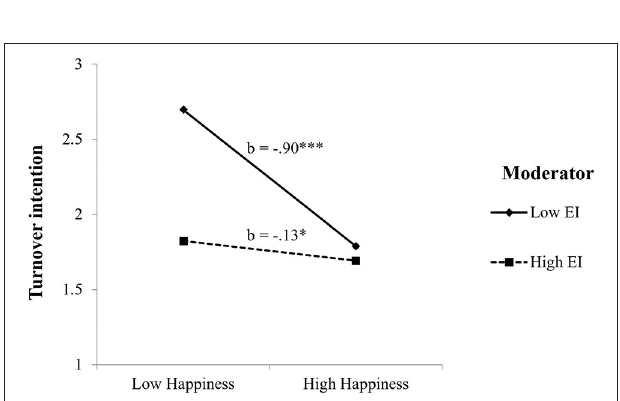
FIGURE 3 | Interaction between EI and happiness on turnover intention. *** p < 0.001, * p < 0.05.